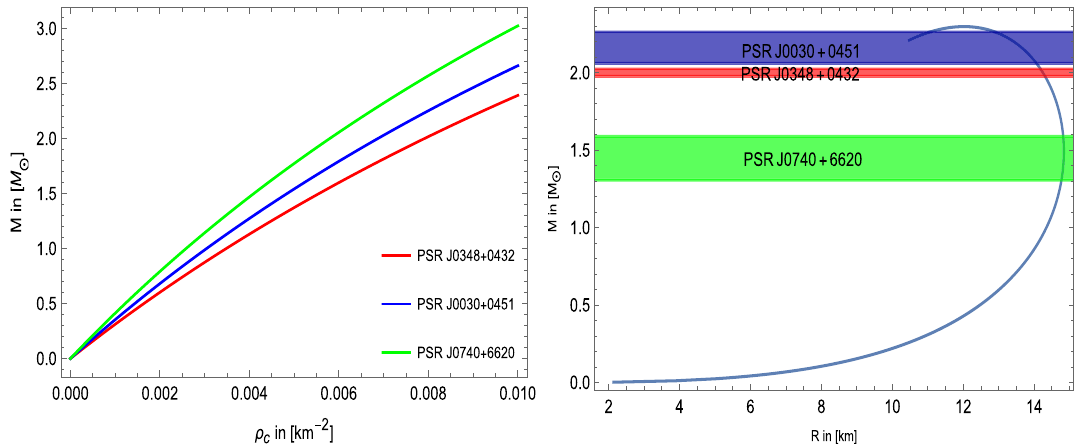
Fig. 4 Behaviour of the gravitational mass ( m ( r )) , compactness parameter ( u ( r )) , and gravitational red-shift ( z s ) against the radial coordinate r of our stellar model for three heavy pulsars. For plotting these graphs, we use the numerical values of the constant parameters given in Table 1